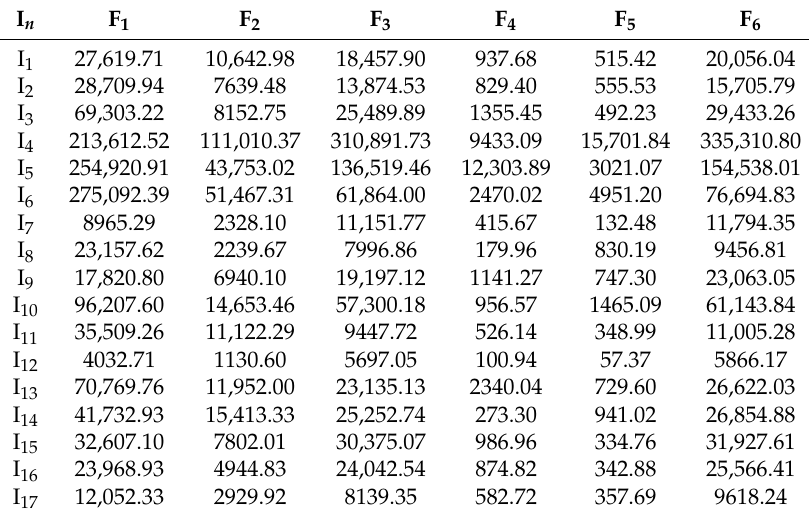
Table 3. Data in 2014.